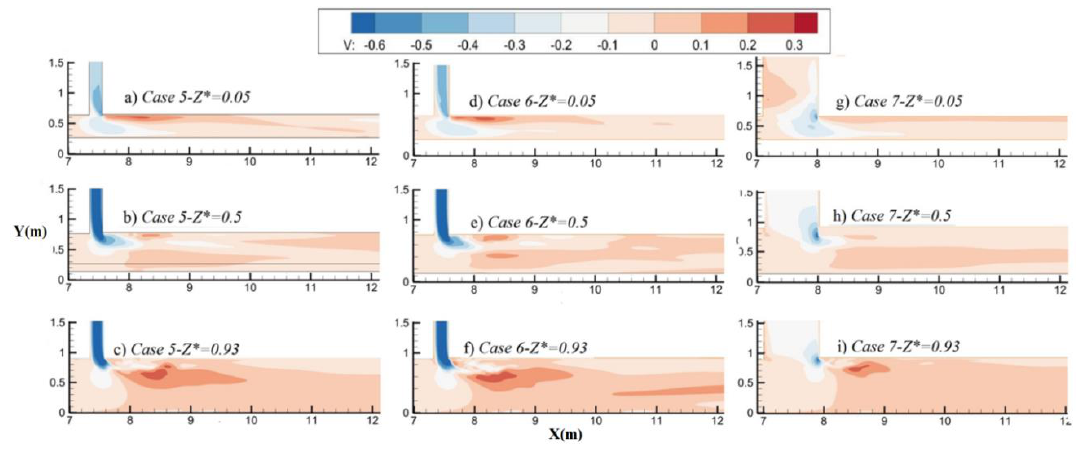
Figure 9. The distribution of the stream-wise component of velocity (U) in trapezoidal channel.